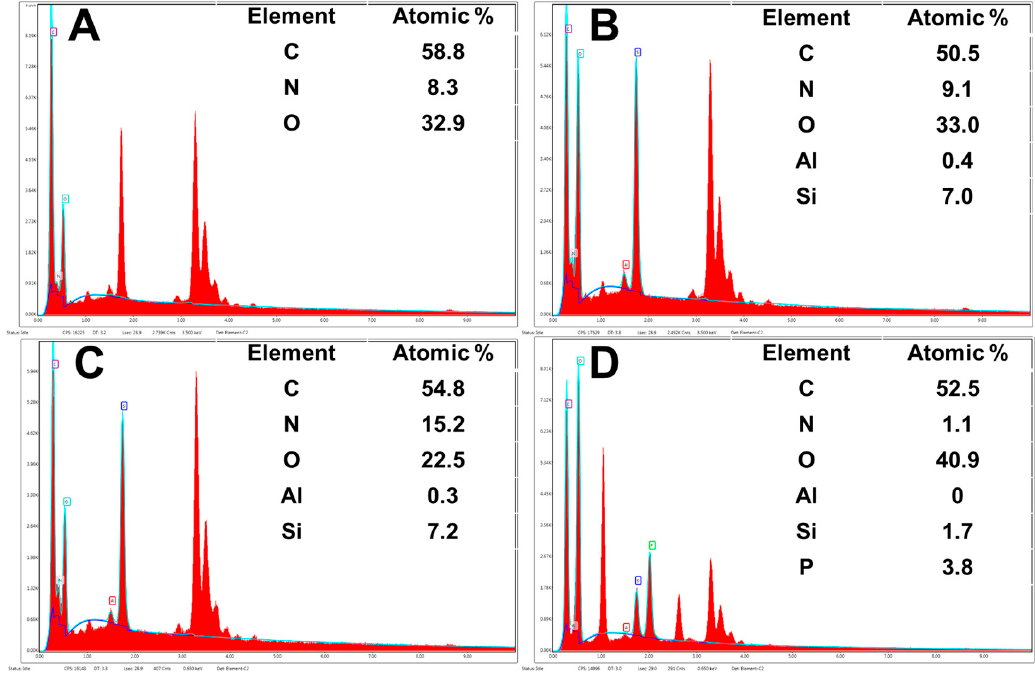
Figure 4. SEM–EDS results of ( A ) PCL–CHIT, ( B ) PCL–CHIT/Mt, ( C ) PCL–CHIT/PAMAM G1 –Mt, and ( D ) PCL–CHIT/PAMAM G1 –Mt/GluO x .